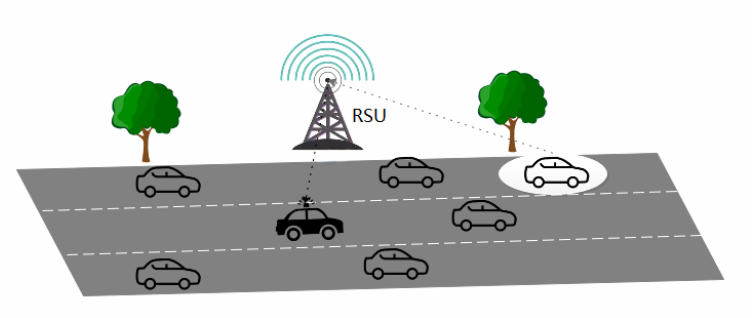
Figure 1. Owing to the limited sensing range of the black vehicle, it requires sensing information from the roadside unit (RSU) to predict the trajectories of surrounding